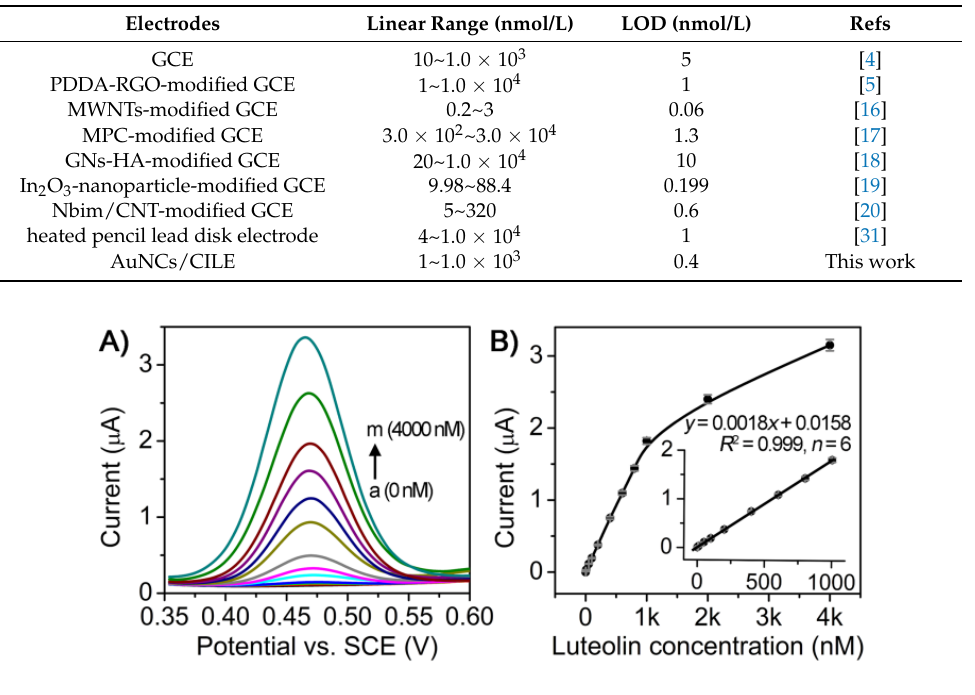
Figure 6. Detection of luteolin standard solution using AuNCs/CILE-based electrochemical sensor. ( A ) DPV curves of different concentrations of luteolin standards on AuNCs/CILE from a tom as 0, 0.001, 0.005, 0.01, 0.05, 0.1, 0.2, 0.4, 0.6, 0.8, 1.0, 2.0, 4.0 μ mol/L; DPV parameters were as follows: pulse amplitude as 0.05 V; pulse width as 0.02 s; pulse period as 0.2 s; and quiet time as 0.5 s; ( B ) Calibration curve generated by plotting the oxidation peak current as a function of luteolin concentration. Inset showed the linear range region of the calibration curve.